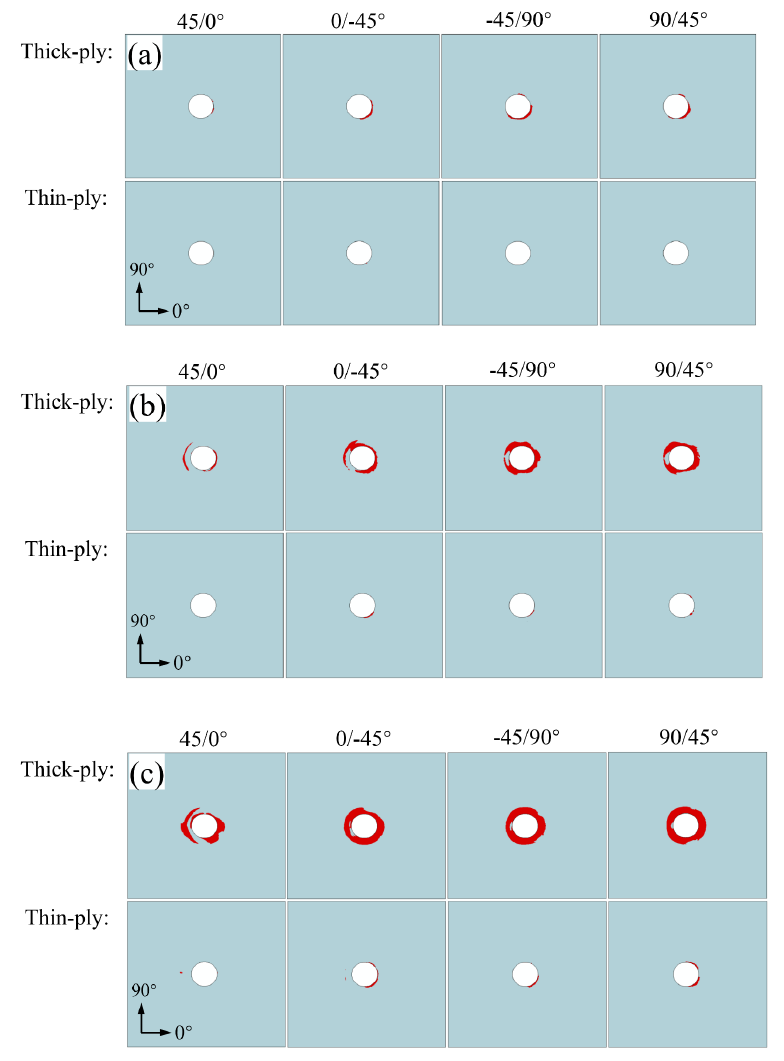
Figure 16. Delamination damage state of thick − ply − laminated and thin − ply − laminated (( a ) 300 MPa, ( b ) 400 MPa, and ( c ) 500 MPa).